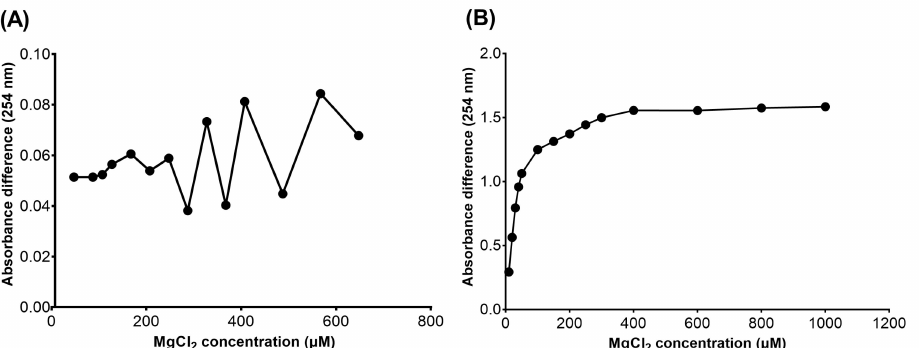
Figure 5. Absorbance increasement at 254 nm of the methanol solution containing 50 µ M 21e in the presence ( A ) or absence ( B ) of NaOAc caused by the addition of ascending concentrations of MgCl 2 . ( A ) Absorbance difference at 254 nm obtained by subtracting the absorbance of the control group (50 µ M 21e ) from that of the sample group (50 µ M 21e , 40–640 µ M MgCl 2 ) containing MgCl 2 . ( B ) Absorbance difference at 254 nm obtained by subtracting the absorbance of the control group (50 µ M 21e , 5 mm NaOAc) from that of the sample group (50 µ M 21e , 5 mm NaOAc, 10–1000 µ M MgCl 2 ) containing MgCl 2